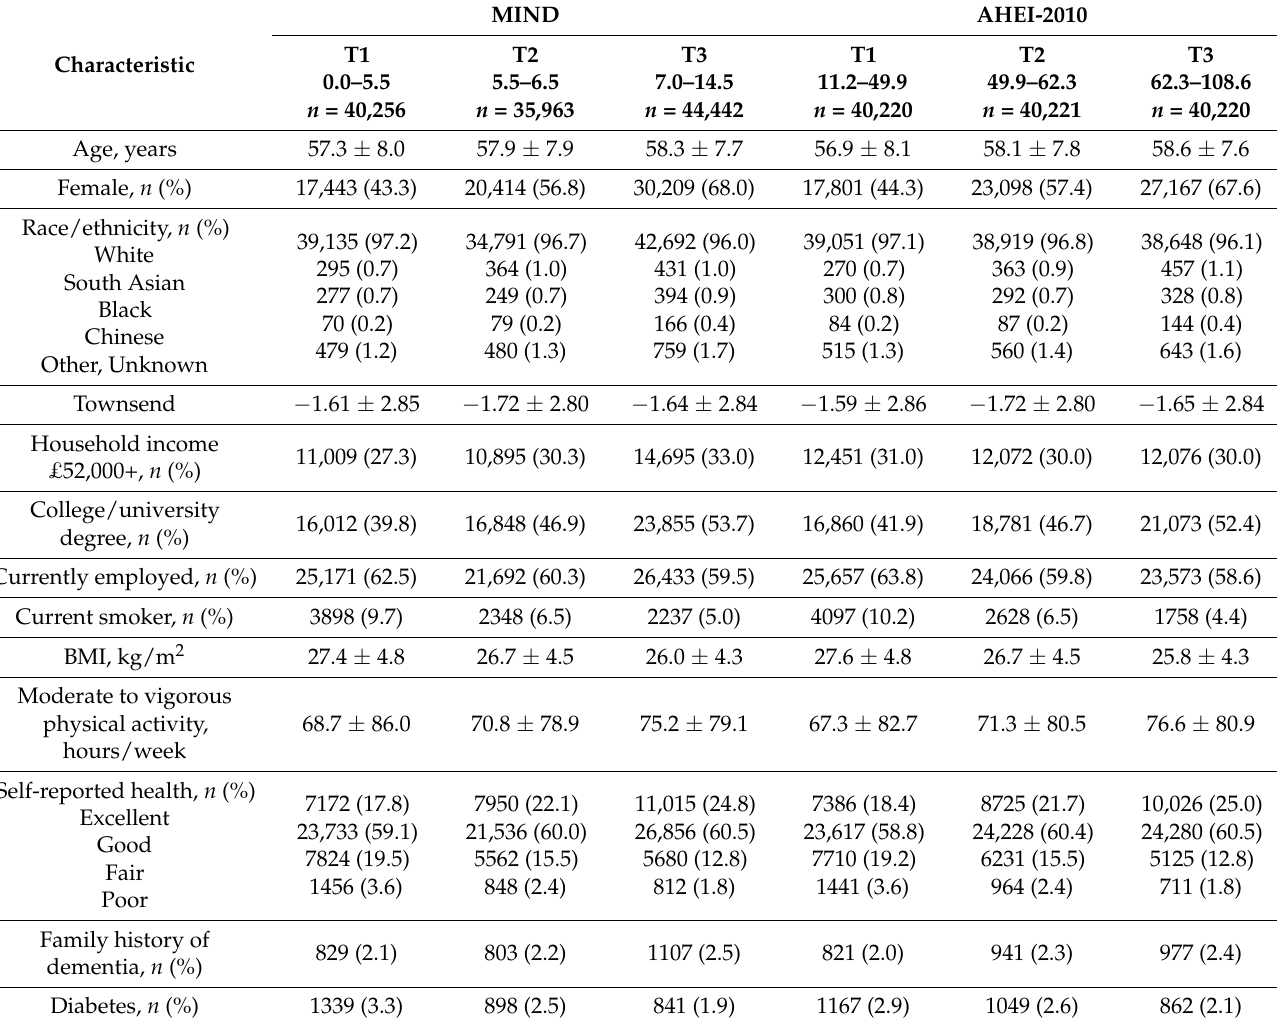
Table 2. Baseline characteristics of participants by tertiles (T) of MIND and AHEI-2010 score 1